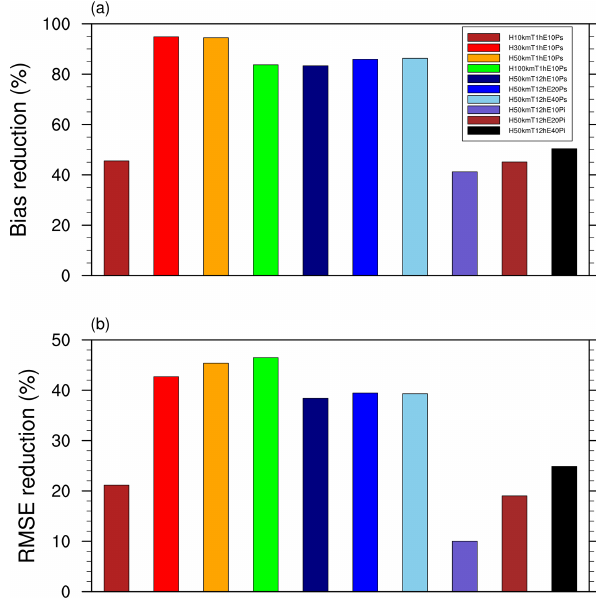
Figure 5. Reductions of the bias and root mean square er- ror (RMSE) between the inverted SO 2 emissions in various data assimilation experiments and the MEIC ones referring to those be- tween the MIX and MEIC SO 2